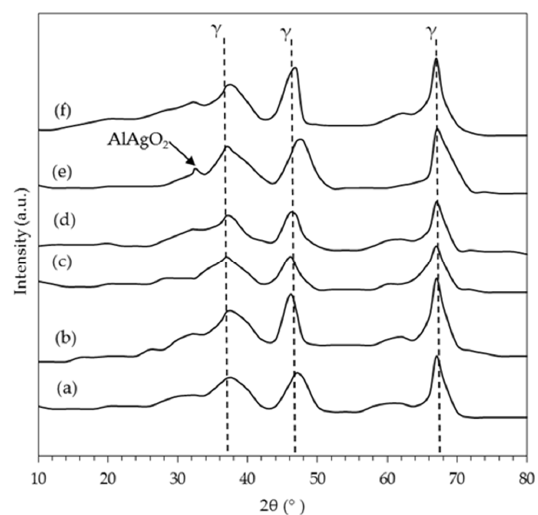
Figure 1. X-ray di ff raction (XRD) patterns of the catalysts: ( a ) 0.4Pt / AW; ( b ) 2Ag / AW; ( c ) 0.1PtAg / AW; Figure 1. X-ray diffraction (XRD) patterns of the catalysts: ( a ) 0.4Pt/AW; ( b ) 2Ag/AW; ( c ) 0.1PtAg/AW; ( d ) 0.25PtAg / AW; ( e ) 0.4PtAg / AW; ( f ) 1PtAg / AW. ( d ) 0.25PtAg/AW; ( e ) 0.4PtAg/AW; ( f ) 1PtAg/AW.